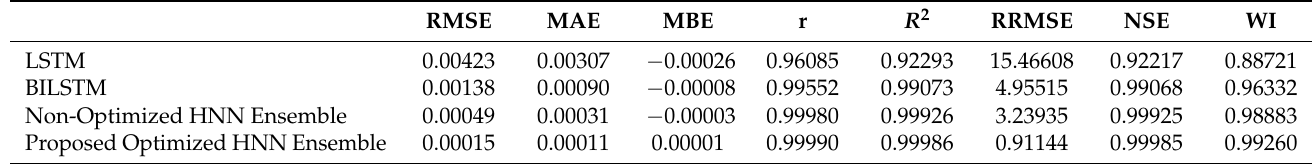
Table 15. Evaluation of the prediction results based on the solar radiation dataset.